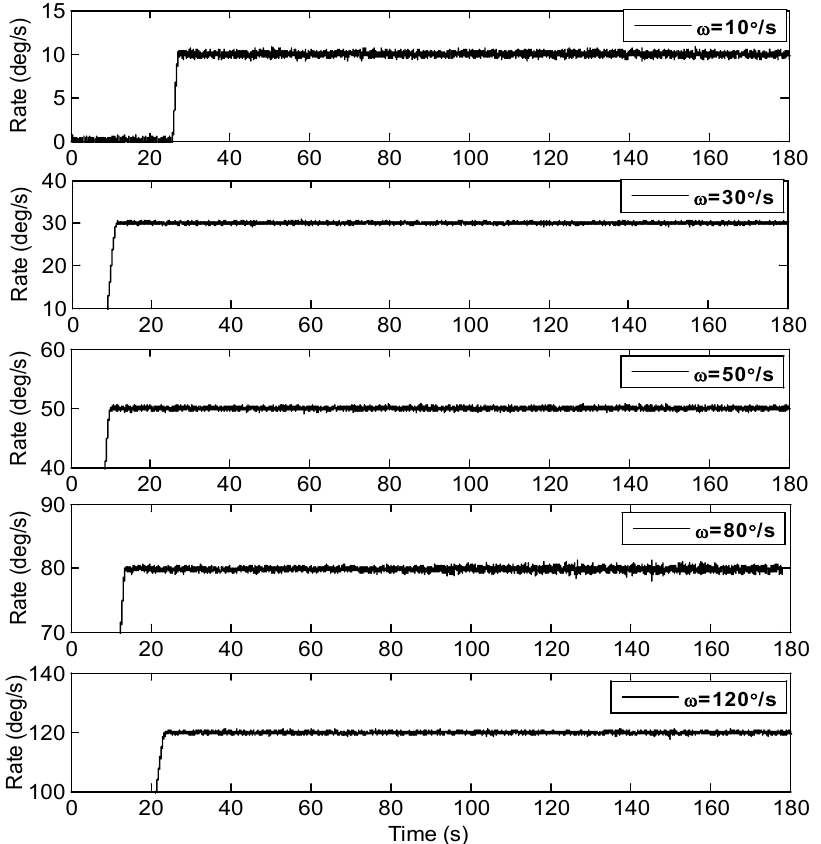
Figure 8. Plot of virtual gyroscope test with constant input rate on the